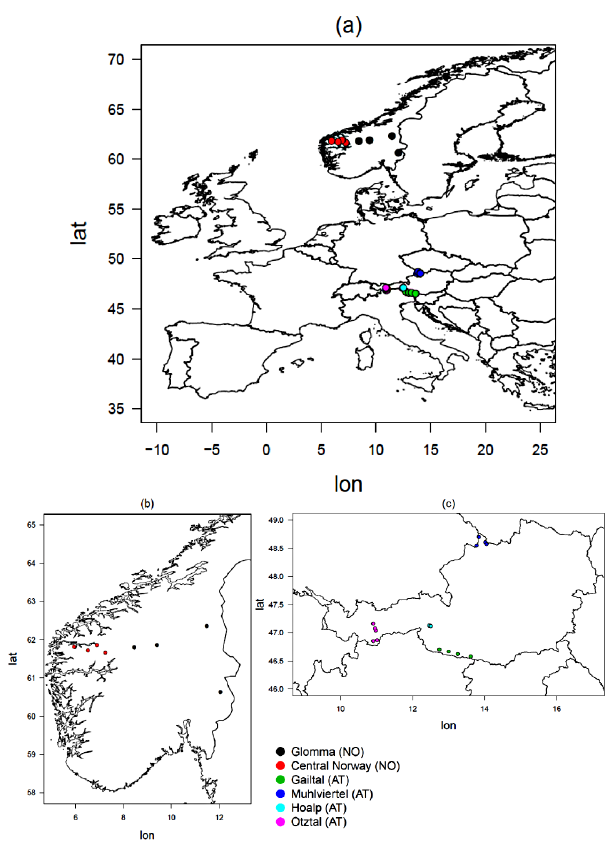
Figure 3. Selected catchments in Norway (b) and Austria (c)